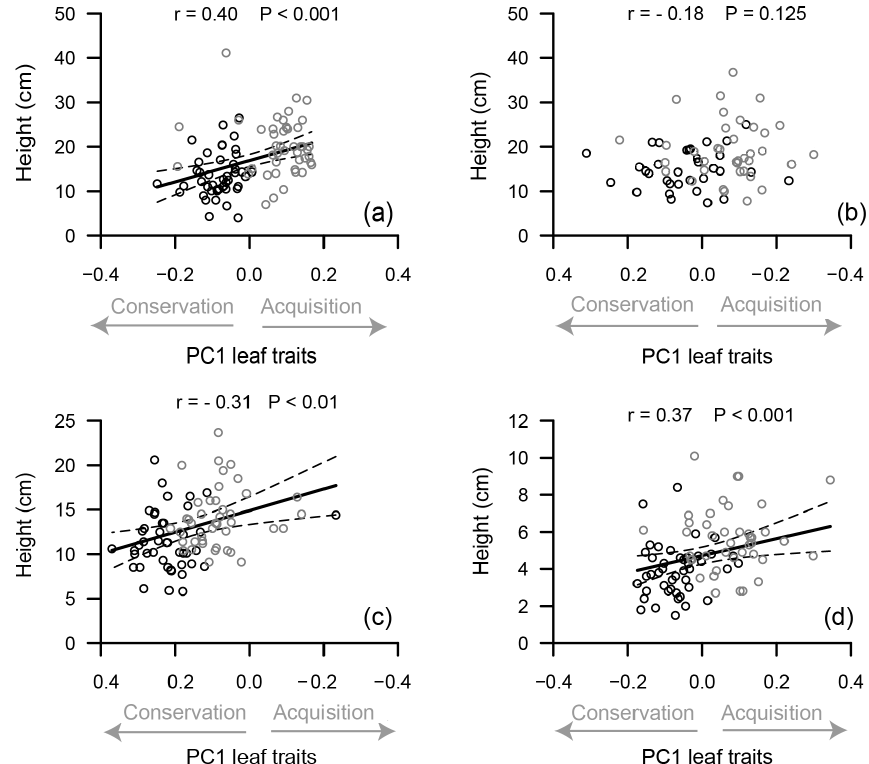
Figure 5. Relationship between plant height and the first axis of the principal component analysis (PC1) of leaf traits for Betula nana (a) , Salix pulchra (b) , Ledum palustre (c) and Vaccinium vitis-idaea (d) . Points are trait values for individuals on unfertilized (black) and fertilized plots (grey). Solid lines are values predicted by the linear mixed-effect model, and dashed lines are the upper and lower limits of the predicted value confidence interval. Pearson’s correlation coefficient ( r ) and p value ( P ) are indicated on each panel. Main leaf traits comprising PC1 are indicated by grey arrows on the x axis and grouped into leaf resource acquisition (higher SLA, LNC and LPC) and conservation traits (higher LDMC and leaf C :